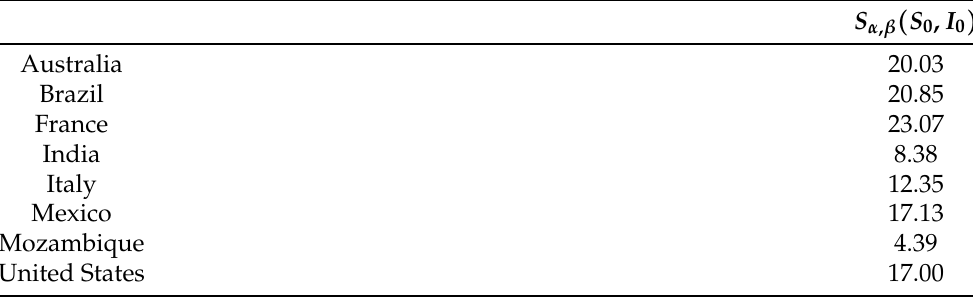
Table 2. Values of the stiffness ratios (3) in France, India, Italy, Mexico and the United States, referring to 2019, assuming the vector (4) as initial